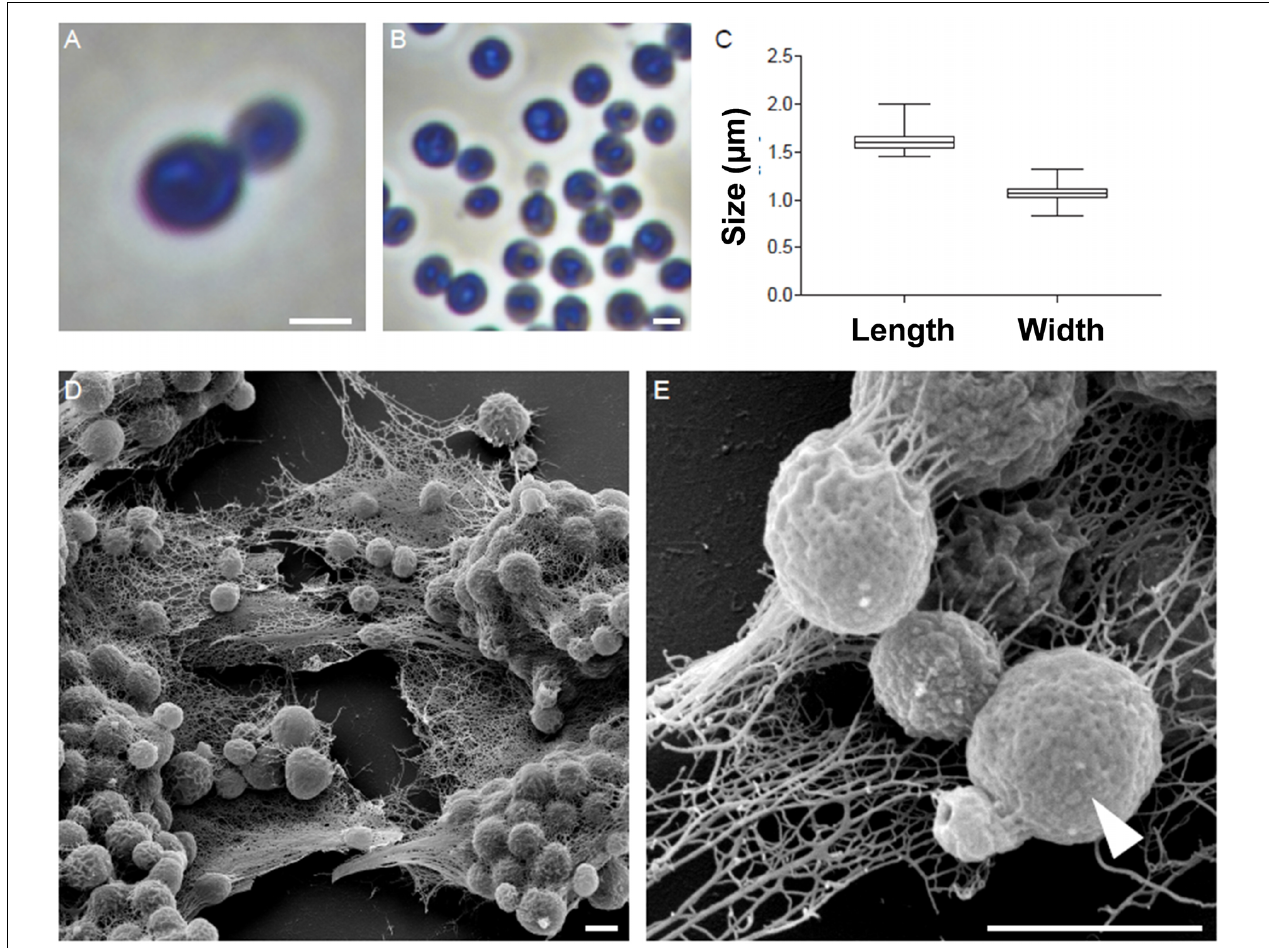
FIGURE 2 | Morphology of strain Enr13 T . Representative phase-contrast and scanning electron microscopic (SEM) micrographs of strain Enr13 T . Round to ovoid cells divide by polar budding (A) . Phase-contrast micrographs show a high variation of structures within the cells (B) . Average cell size ( n = 500): 1.6 ± 0.1 µ m in length and 1.1 ± 0.1 µ m in width (C) . Cells form dense biofilms with high amounts of exopolysaccharides (D) . Individual cells are surrounded by a wrinkled layer or show crateriform structures (arrow head) on their surface (E) . Scale bar: 1 µ